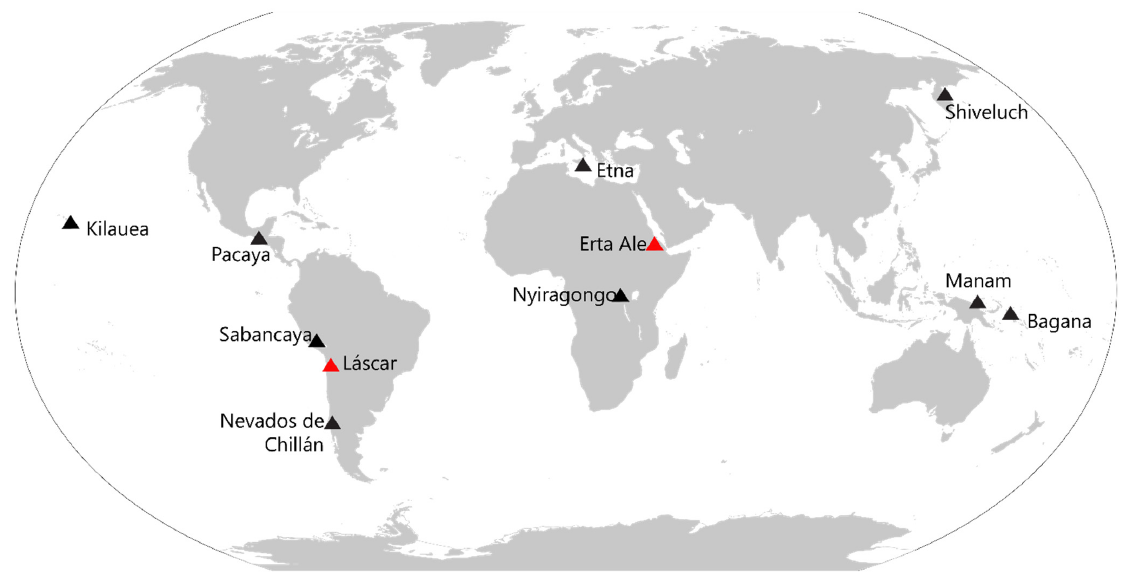
Figure 1. Geographic locations of volcanoes investigated in this paper. Red triangles indicate the two case studies (Láscar and Erta Ale volcanoes) for which we compared 9 years of nightime data using MIROVA VIIRS , MIROVA MODIS, and FIRMS VIIRS algorithms (see Section 4); black triangles represent the volcanoes for which we compare the MIROVA VIIRS and MIROVA MODIS algorithm to test the full potentiality (nighttime and daytime) of VIIRS for global thermal monitoring (see Section